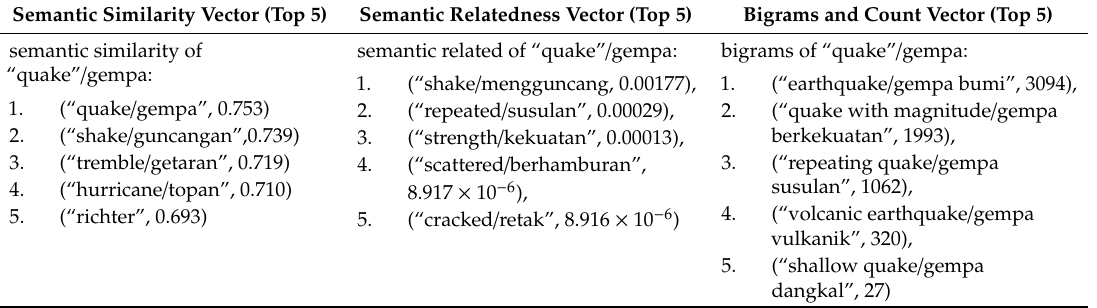
Table 5. Event keyword-features for quake